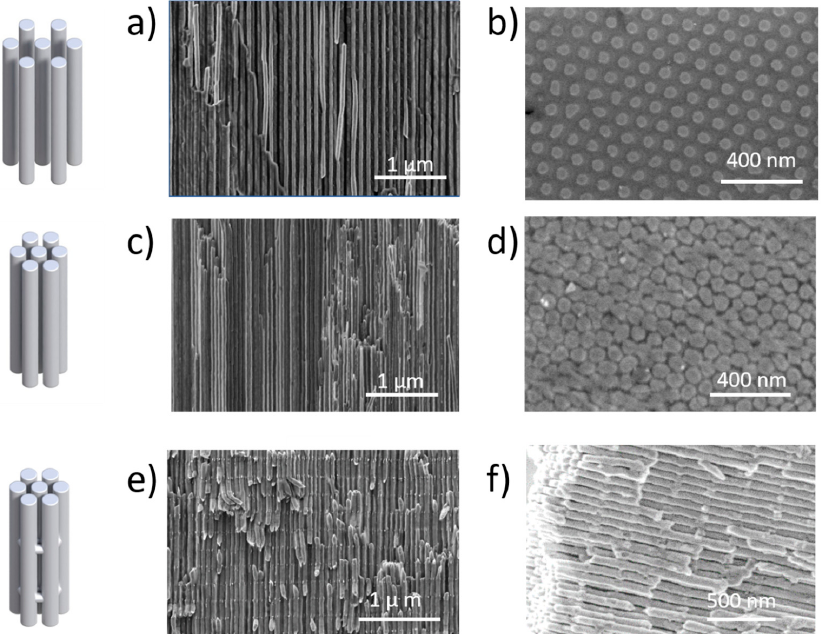
Figure 3. Scanning electron microscopy images of the different nanostructures fabricated with Ni, along with the schemes shown in Figure 1 (displayed in the left hand of the figure) corresponding to the right SEM images. ( a , b ) correspond to the 1D nanowire array with the nanowire inter-distance of 100 nm (side and top views, respectively), before dissolving the AAO template, ( c , d ) correspond to the 1D nanowire array with 65 nm of inter-wire distance (side and top views, respectively), and ( e , f) correspond to the 3D nanowire network, inside the alumina template and self-standing, once the 3D-AAO has been dissolved, respectively.